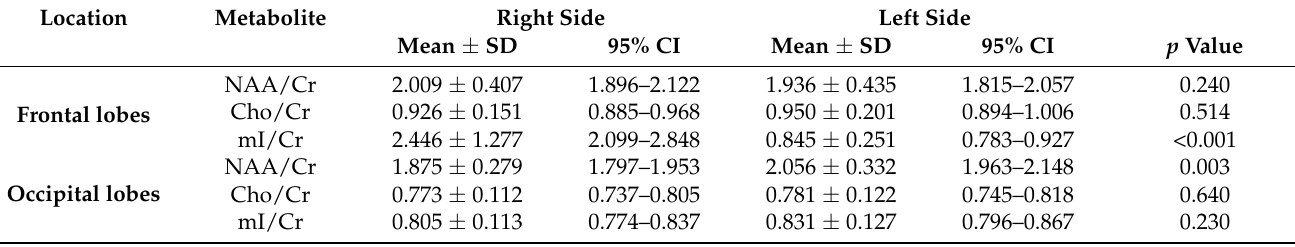
Table 4. The comparison of the relative concentrations of metabolites in the right and left frontal and occipital lobes of soldiers preferring a right shooting